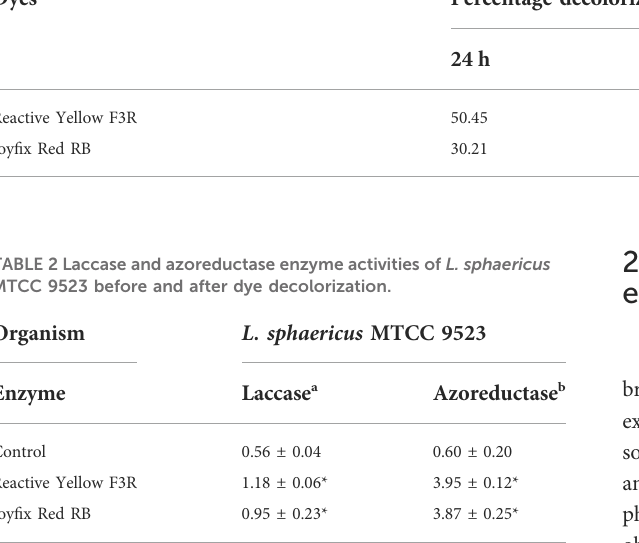
TABLE 1 Decolorization percentage for the dyes treated by L. sphaericus MTCC 9523.